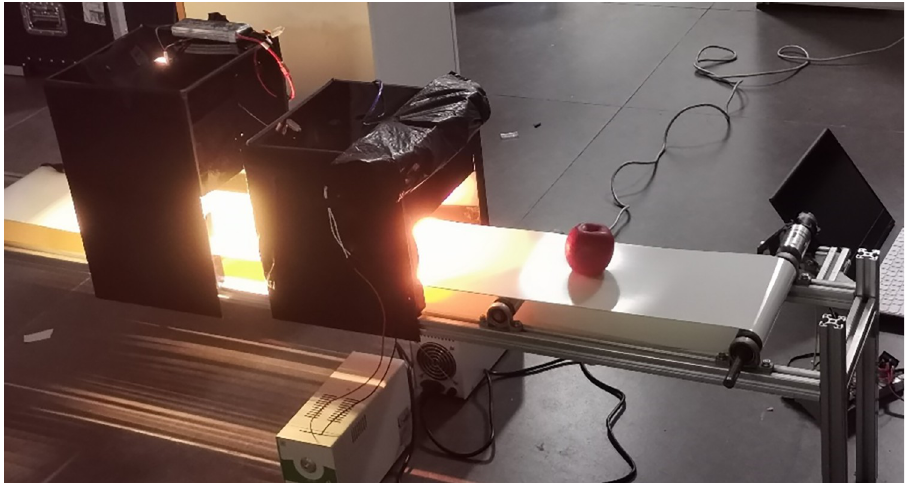
Fig 16. The prototype of the apple quality detection